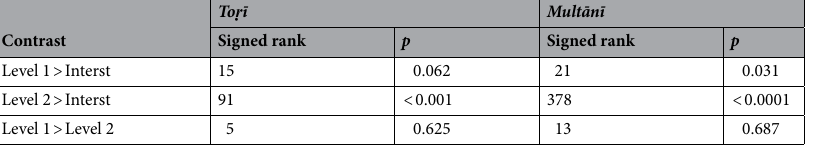
Table 3. The Wilcoxon signed rank test statistic and its p value, for pairwise comparisons of click densities between region types.